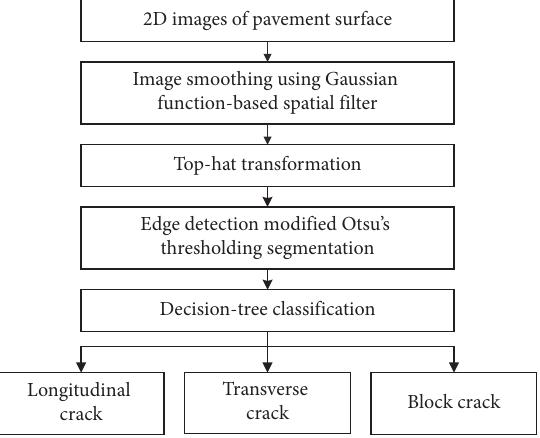
Figure 1: Flowchart of the